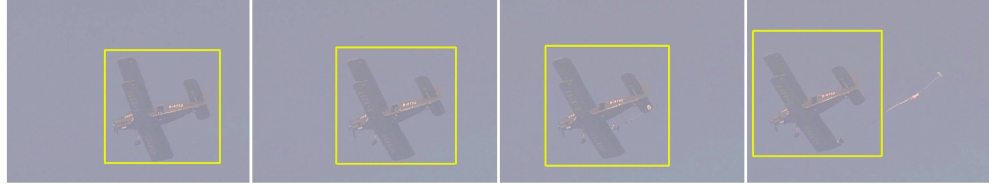
Figure 11. The optical flow to track the aircraft